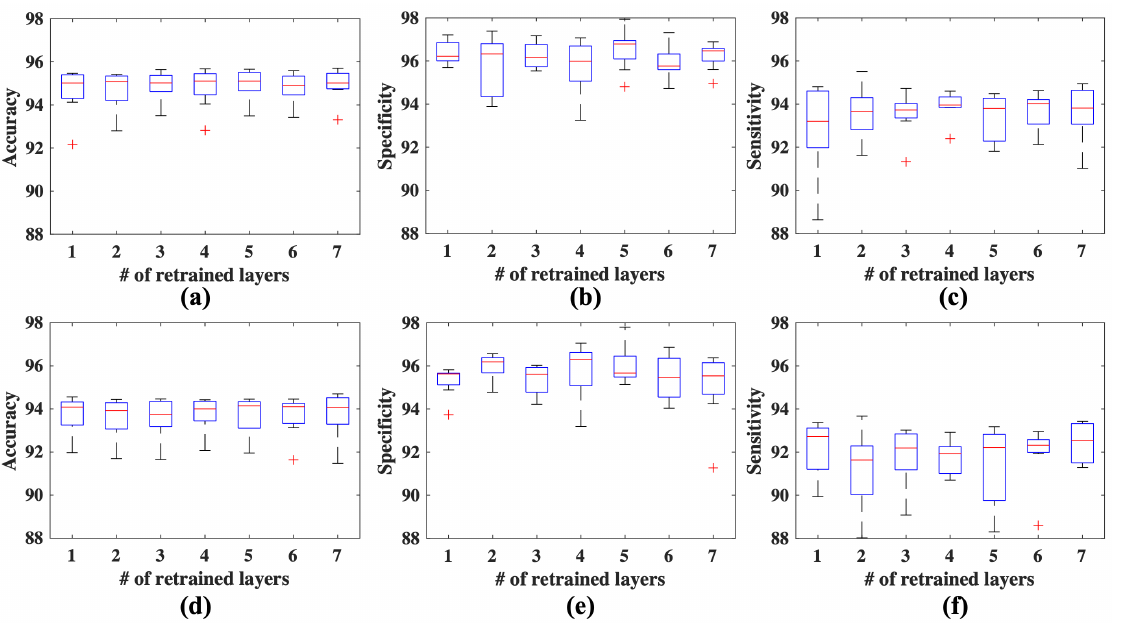
Figure 10. Effect of the number of retrained layers when the baseline U-notch DNN is re-trained with V-notch data to enable a prediction for V-notch: ( a ) accuracy, ( b ) specificity, and ( c ) sensitivity. Effect of the number of the retrained layers when the baseline V-notch DNN is retrained with U- notch data to enable a prediction for U-notch: ( d ) accuracy, ( e ) specificity, and ( f ) sensitivity. All the distributions indicate the variation for the corresponding retrained layers across different percentage of training data. The box plot for 1 retrained layer in ( a ) is a distribution of eight different accuracies corresponding to different percentage of training data.